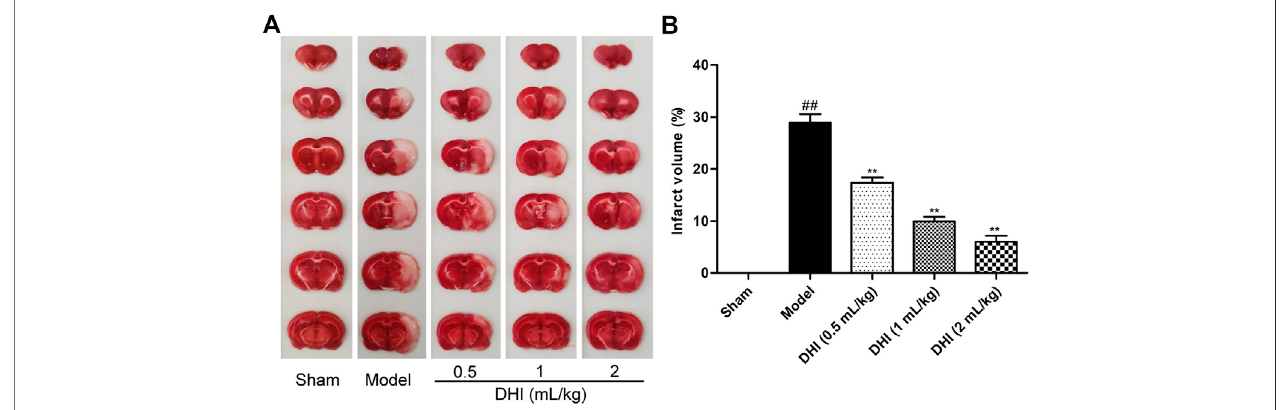
FIGURE 2 | Effects of DHI on cerebral infarct volume in rats by TTC staining. (A) Representative images of TTC staining in all groups. (B) Results of cerebral infarct volumes in all groups. Mean ± SD ( n (cid:2) 6). Asterisks denote the signi fi cant levels: ## P < 0.01 vs. sham group and ** P < 0.01 vs. model group.